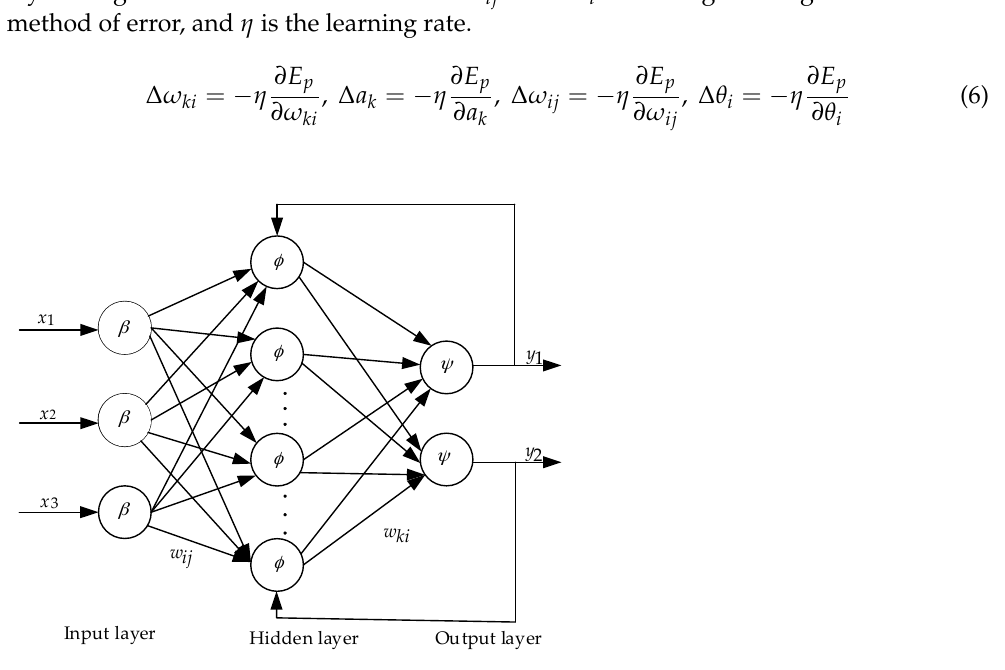
Figure 9. Simplified schematic of the BPNN structure.